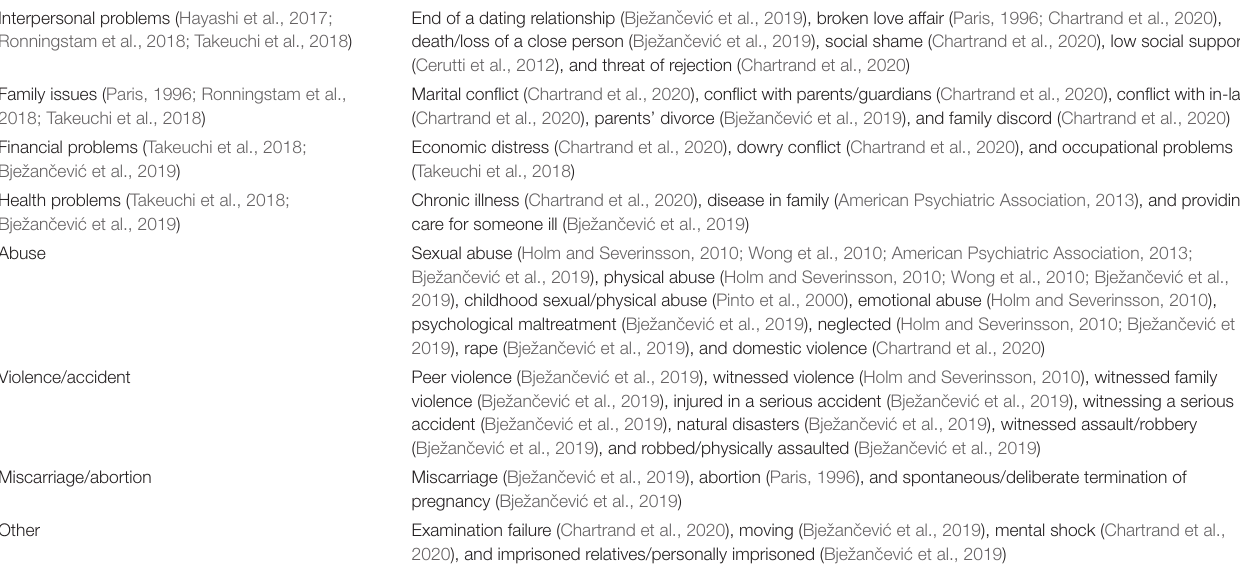
accident (Bježanˇcevi´c et al., 2019), natural disasters (Bježanˇcevi´c et al., 2019), witnessed assault/robbery (Bježanˇcevi´c et al., 2019), and robbed/physically assaulted (Bježanˇcevi´c et al., 2019)